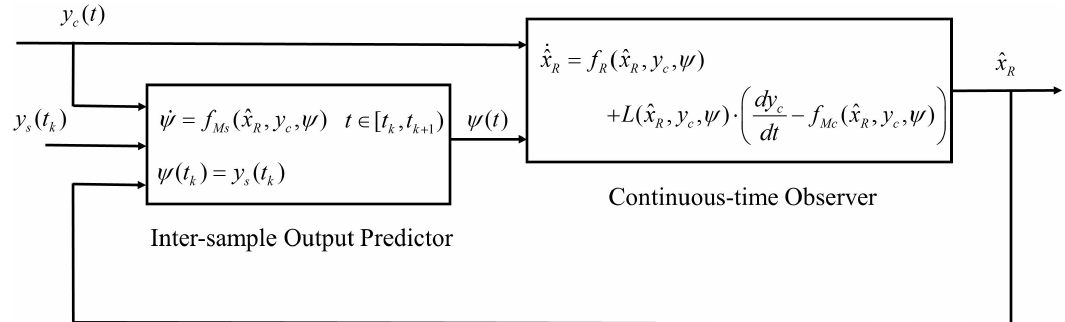
Figure 2. Structure of the reduced-order sampled-data